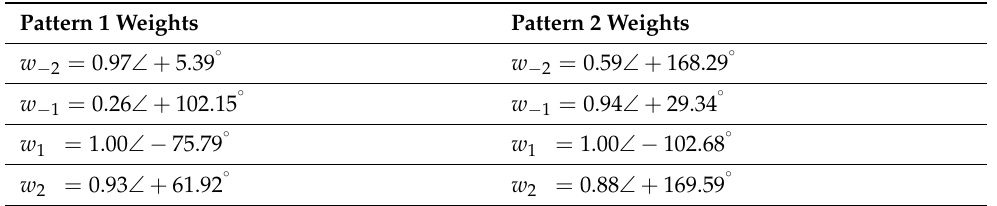
Table A6. Array weights of the conformal antenna on the cylindrical-shaped surface with r = 10 cm with coupling using